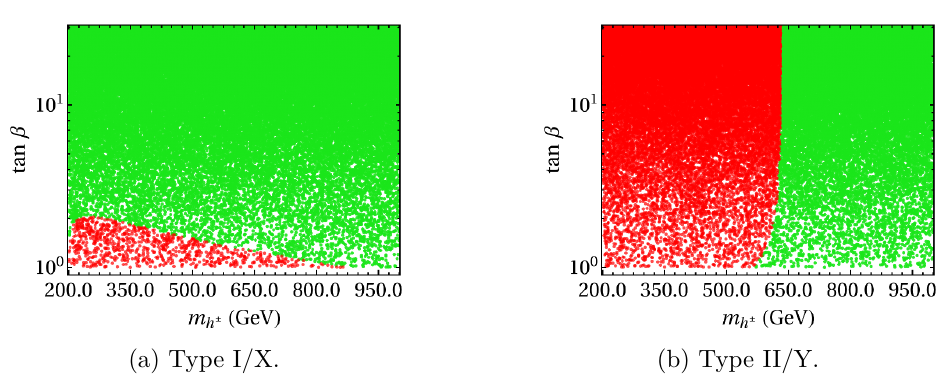
Figure 1 . Allowed (green) and excluded (red) regions in the plane tan β and m